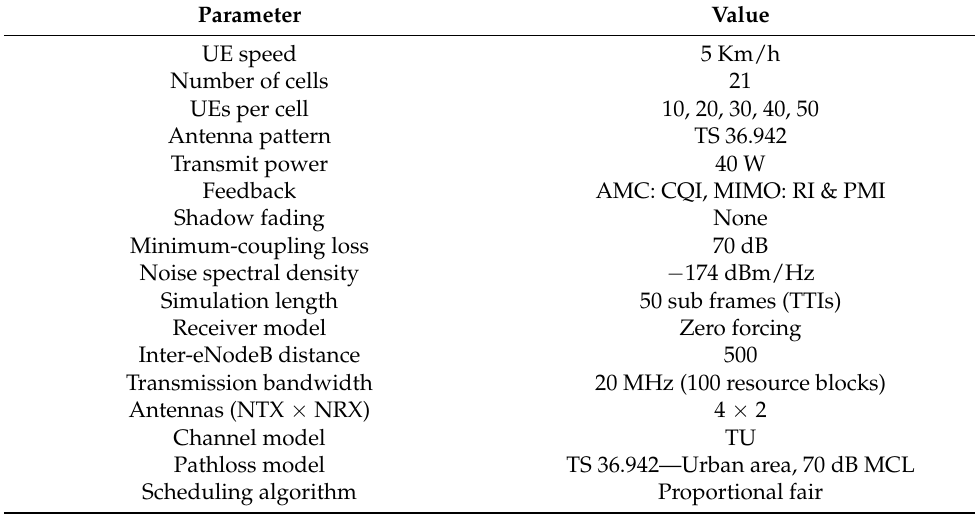
Table 1. Parameters used for the LTE FFR